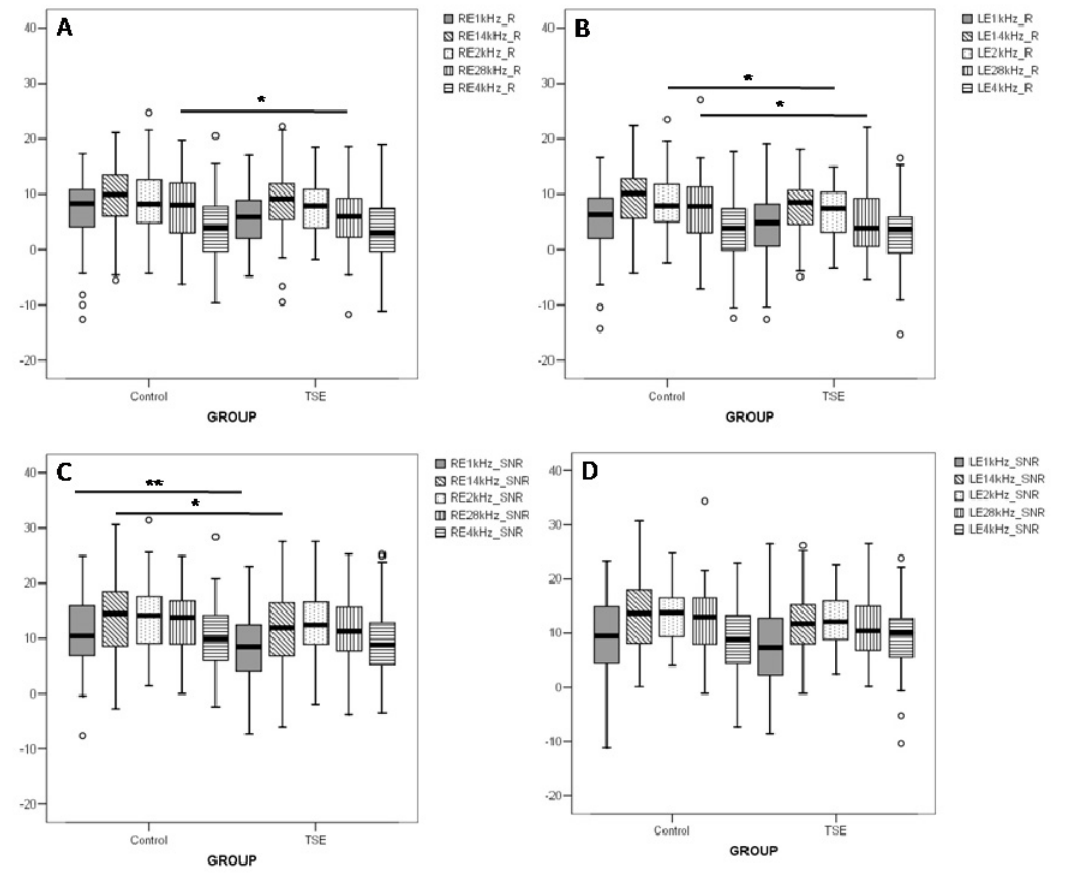
Figure 2. Frequency band TEOAE response level and signal/noise response level of right (RE) and left (LE) ears of tobacco smoke exposure (TSE) students and their controls. Upper bars indicate comparison between groups per ear. * p ≤ 0.05 and ** p ≤